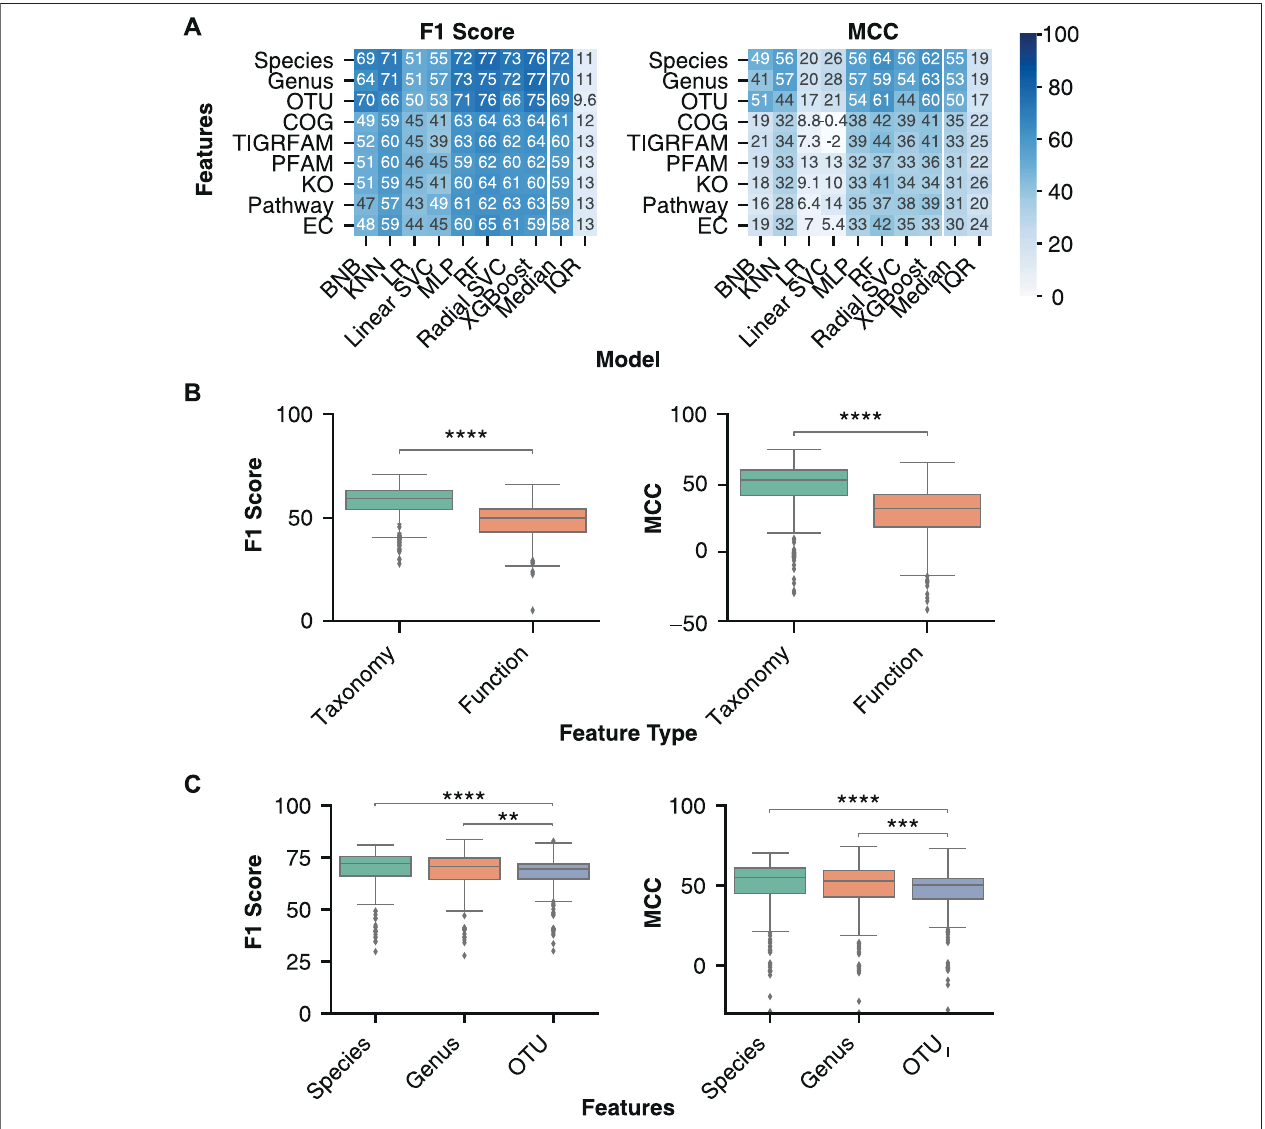
FIGURE 3 | Optimal disease classi fi cation of microbiome samples obtained with taxonomic features. (A) Median performance of the three taxonomy and six functional feature sets for each ML model architecture. Rows were sorted in descending order by the mean column followed by the standard deviation (SD) column. (B) Distributionofperformancemetricsfortaxonomyandfunctionalfeaturesacrossallnormalizationortransformation,batcheffectcorrection,andmodelcombinations. (C) Distribution of classi fi cation performance with the three taxonomic feature sets. Independent Mann-Whitney U tests were performed to compare aggregate performance of taxonomy and functional features. The analysis was limited to all normalizations and transformations (ILR, CLR, VST, ARS, LOG, TSS, NOT) and batch effect correction (only no batch effect correction or zero centering) methods that were performed on all feature sets. ** indicates p -value < 0.01, *** indicates p -value < 0.001, **** indicates p -value <